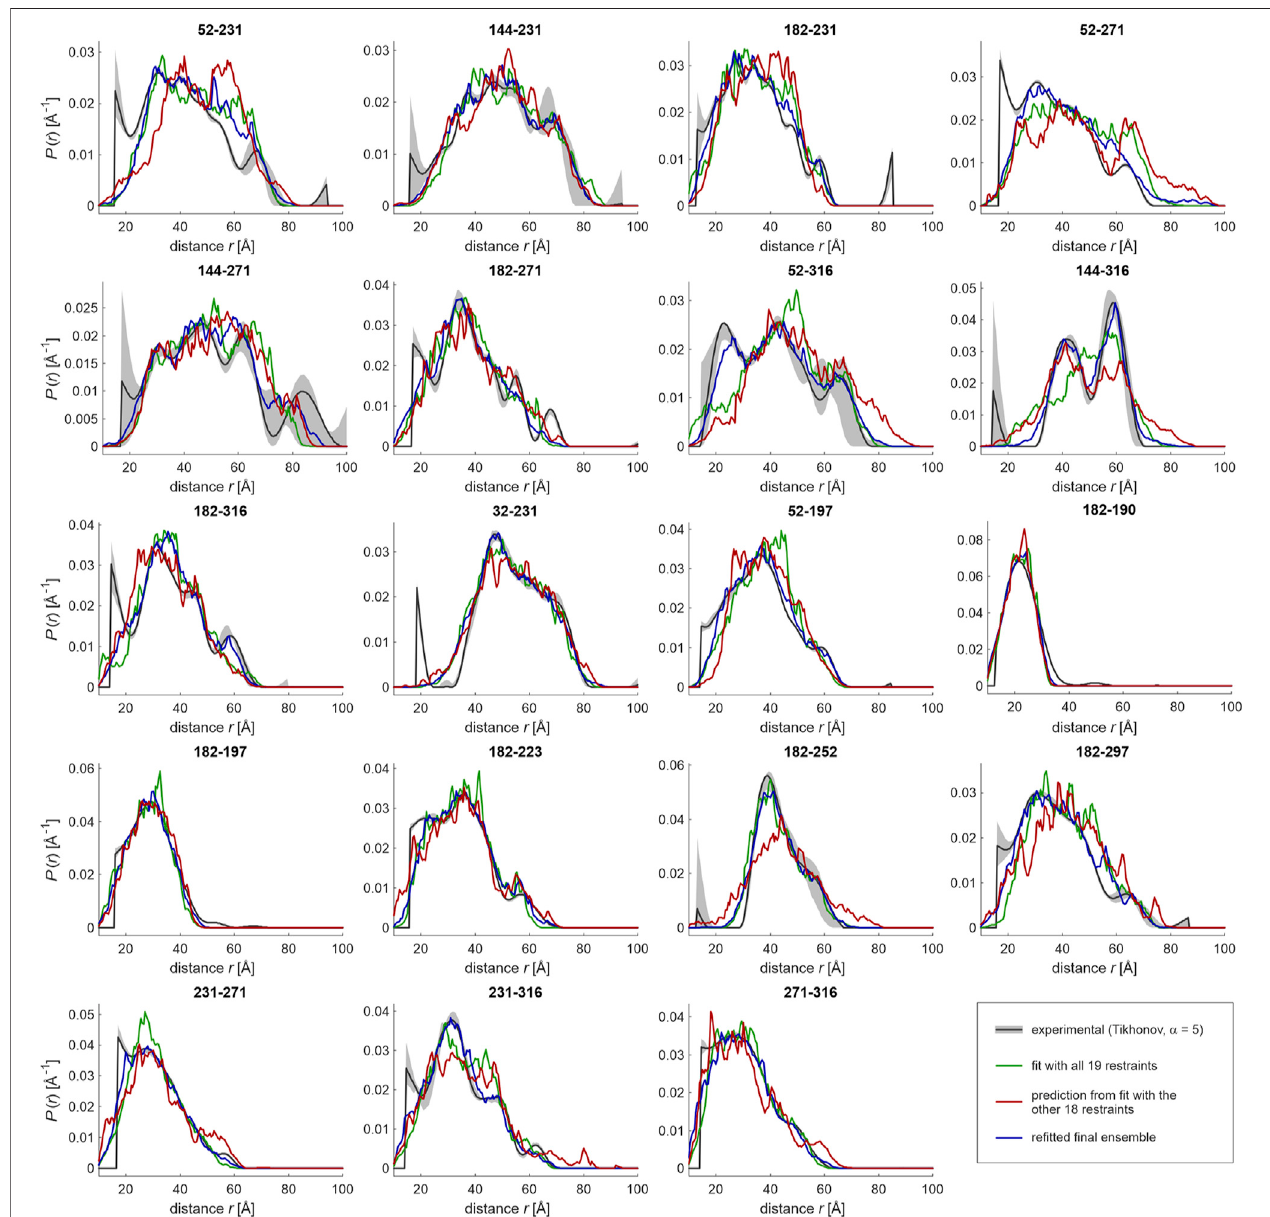
FIGURE 5 | Ensemble fi tting of the LCD (residues 188 – 320) of hnRNP A1 with jack-knife resampling. A raw ensemble of 331 conformers was generated based on Gaussian restraints. Conformer populations were fi tted by maximizing geometric mean overlap between simulated (green) and experimental (black) distance distributions. Conformerswith less than 1% ofthepopulationof themost populatedconformer were discarded,resulting ina re fi ned ensemble with60 conformers. The procedurewasrepeatedwithallpossiblesetsof18outofthe19restraints,givingslightlydifferentsizesoftherawandre fi nedensembles.Theunusedrestraintwas predicted from the “ leave-one-out ” ensemble (red). All conformers found in individual ensembles during jack-kni fi ng were combined with the 60 conformers in the initial ensemble and used as the basis set for the fi nal ensemble fi t (blue lines).